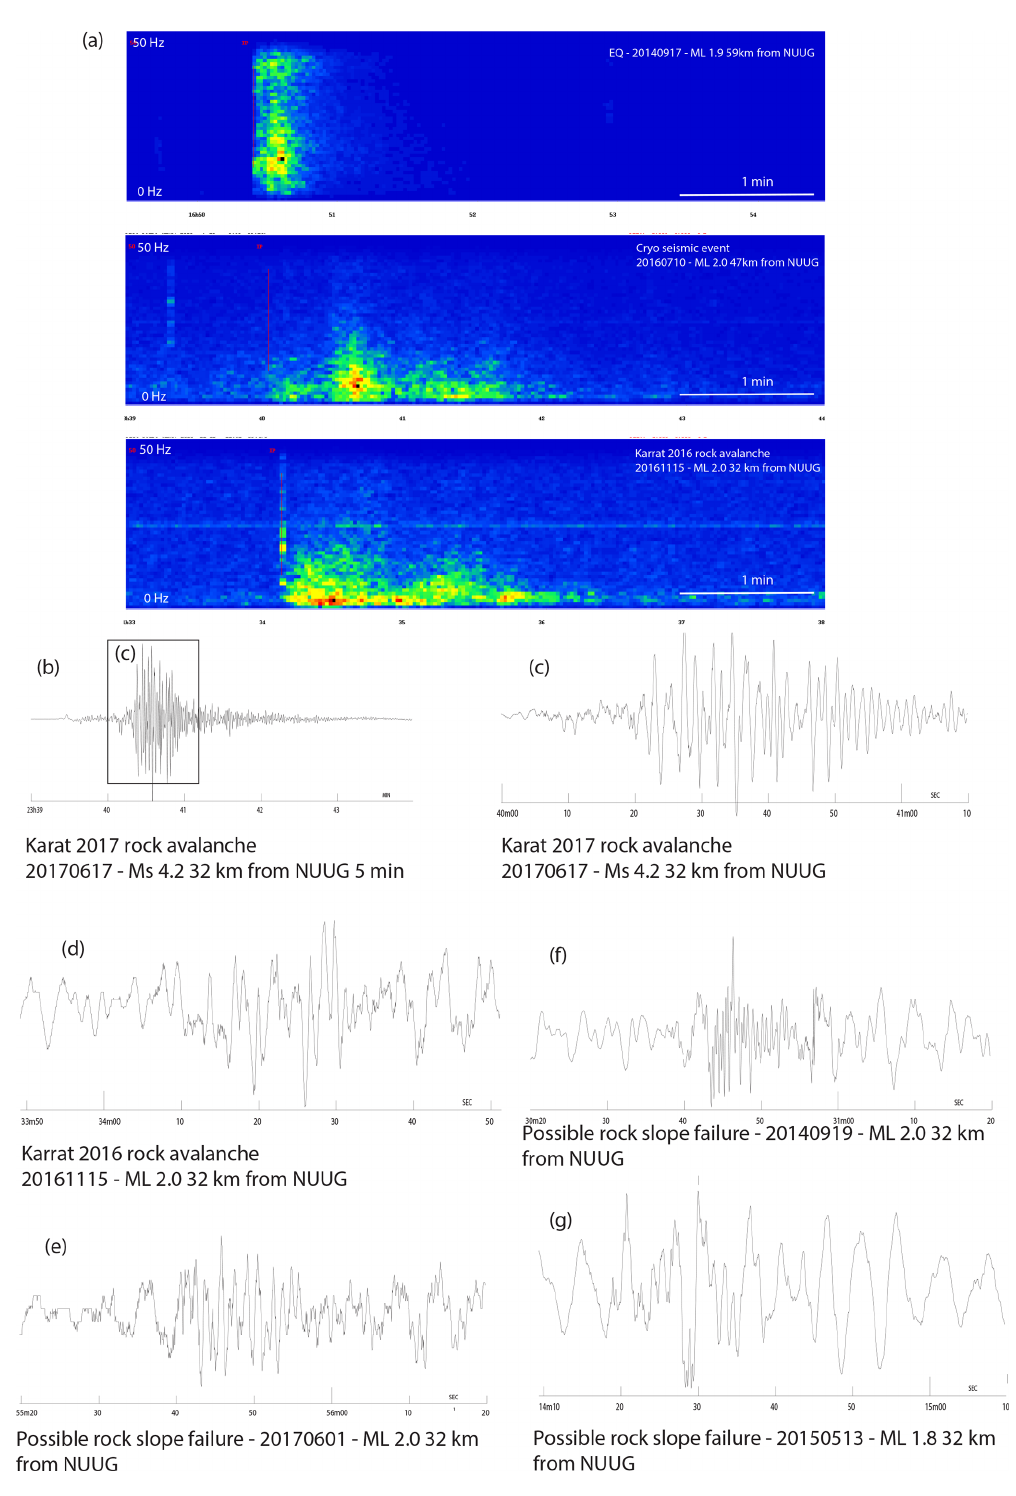
Figure 6. Seismic signatures of major events. All figures show the unfiltered data of the vertical component from the seismic station at Nuugaatsiaq (NUUG). Panel (a) consists of spectral plots of a tectonic earthquake (top), a cryo-seismic event (middle), and a confirmed rock avalanche (bottom). The difference in frequencies and duration between the tectonic event and the non-tectonic events is clear, while the difference between the two non-tectonic events (cryo-seismic and rock avalanche) is more ambiguous. Panel (b) is a 5min extract of the Karrat 2017 rock avalanche. Panels (c) – (g) are 1min and 10sec extracts for possible and confirmed rock avalanche events from NUUG. Panels (c) and (d) are known rock avalanches (Karrat 2016 and Karrat 2017), and panels (e) – (g) are interpreted as possible rock slope failures in the Karrat area, but this is not supported by the other